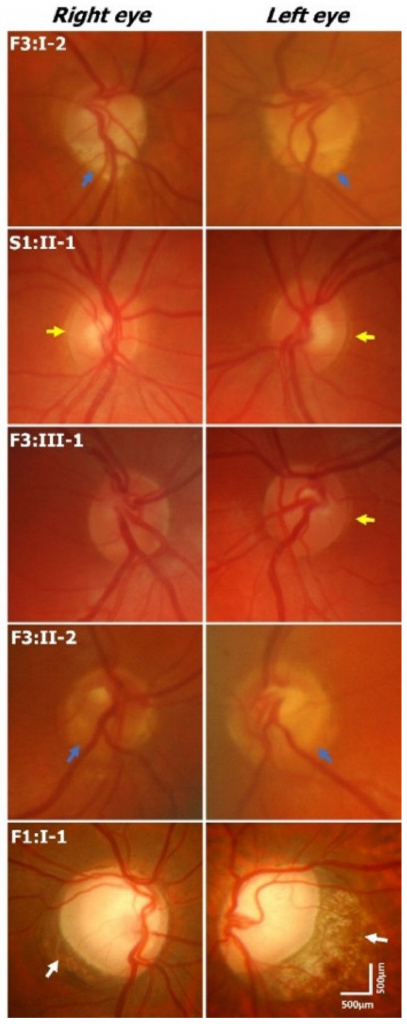
Figure 2. Fundus photos of subjects with CFEOM. In subject F3:1-2, the disc appears tilted with a small cup and inferior yellowish mottled halo (blue arrows). There is situs inversus of the blood vessels. Subject S1:II-1 has a faint halo surrounding the disc, which is a subtle incomplete double ring (yellow arrows). This is also seen in the left eye of subject F3:III-1, with an abnormal course of retinal vessels seen in both eyes. Subject F3:II-2 has hypoplastic optic nerves with significant inferior peripapillary scleral halos (blue arrows). Abnormal course of retinal vessels is seen. Subject F1:I-1 has tilted disc with myopic crescent (white arrow) and significant disc excavation and pallor. Scale bar represents 500